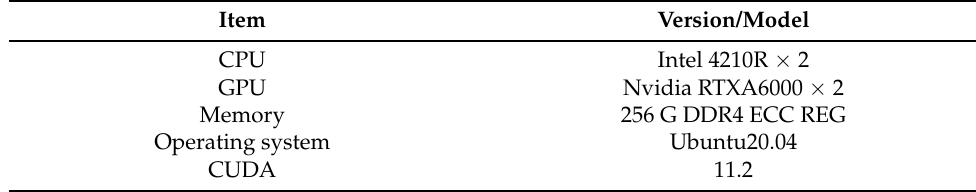
Table 4. Related experimental